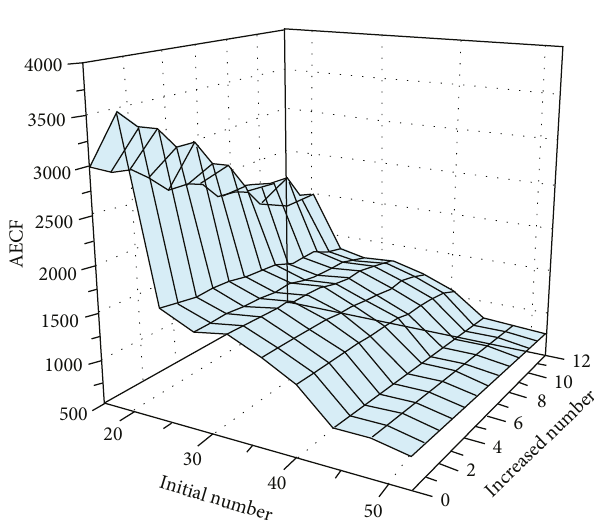
Figure 7: Veri fi cation on 50 × 50 scale SPMA.